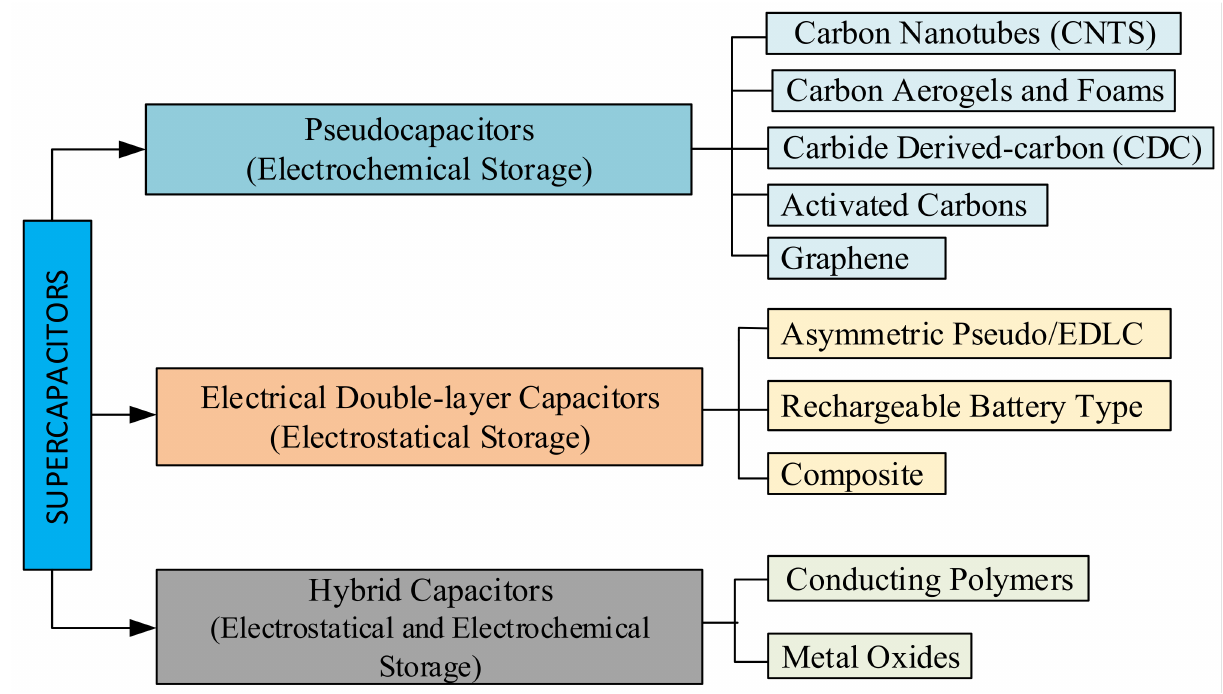
Figure 4. Classification diagram of SCs